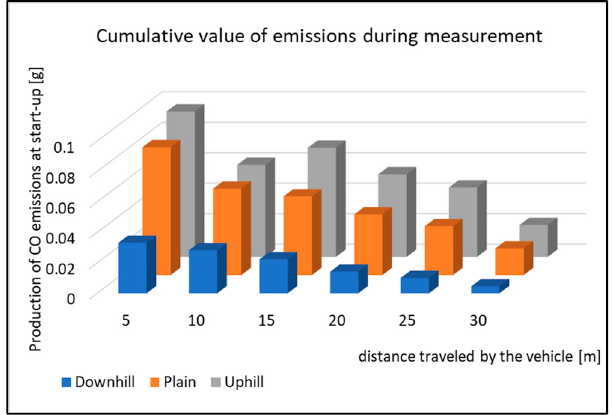
Figure 12. Cumulative value of emissions CO during measurement.